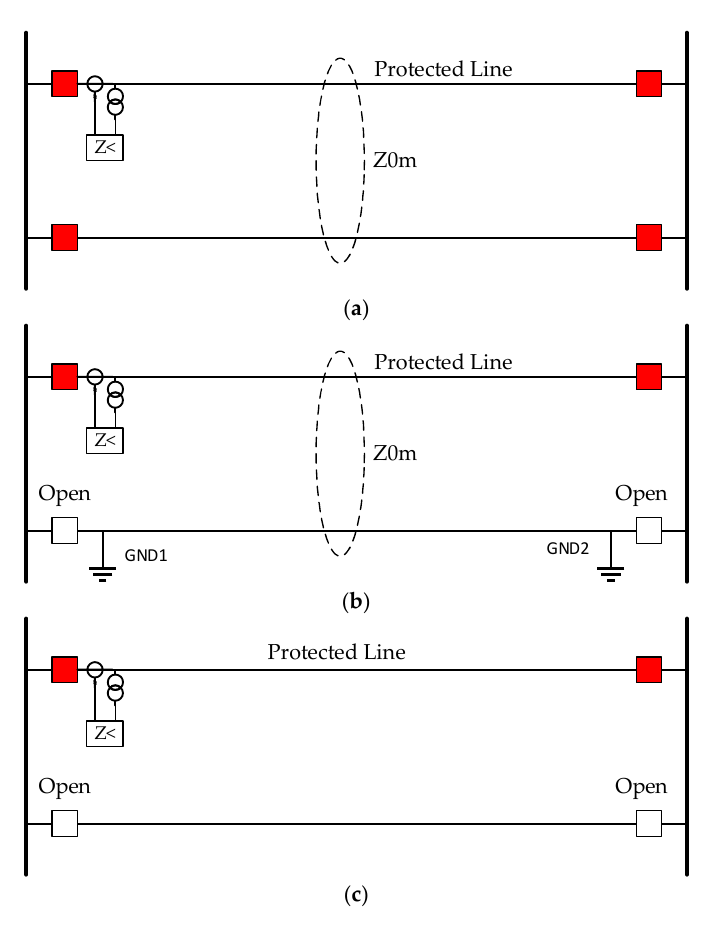
Figure 3. Different operating conditions of two mutually coupled transmission lines: ( a ) Both lines are in service; ( b ) The mutually coupled line is out of service and grounded at both line ends; ( c ) The mutually coupled line is out of service and ungrounded at both line ends.